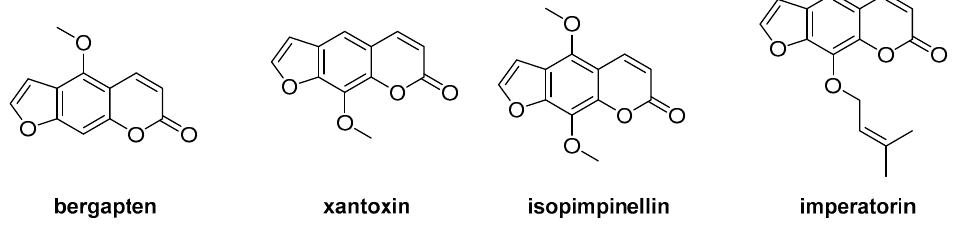
Figure 19. Coumarins isolated from Rutacea species.